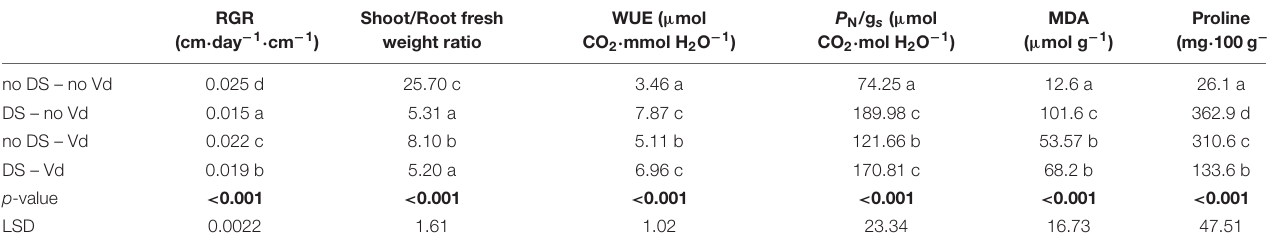
TABLE 3 | Effect of Verticillium dahliae infection and drought stress on eggplant developmental, physiological and biochemical